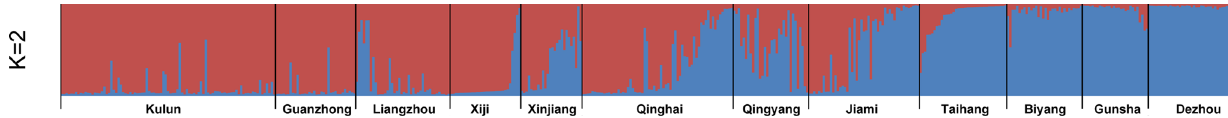
Figure 3. Population structures of 12 Chinese indigenous donkey breeds assuming K = 2.